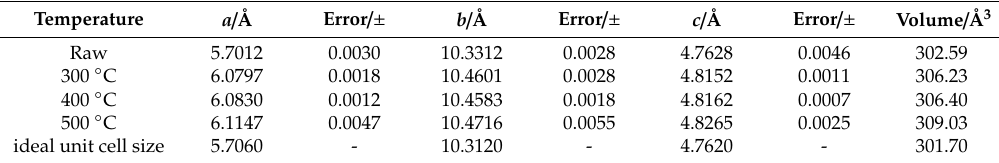
Table 3. Unit cell parameters of Fe 2 SiO 4 in nickel slag material and products after oxidation at 300–500 ◦ C. Temperature